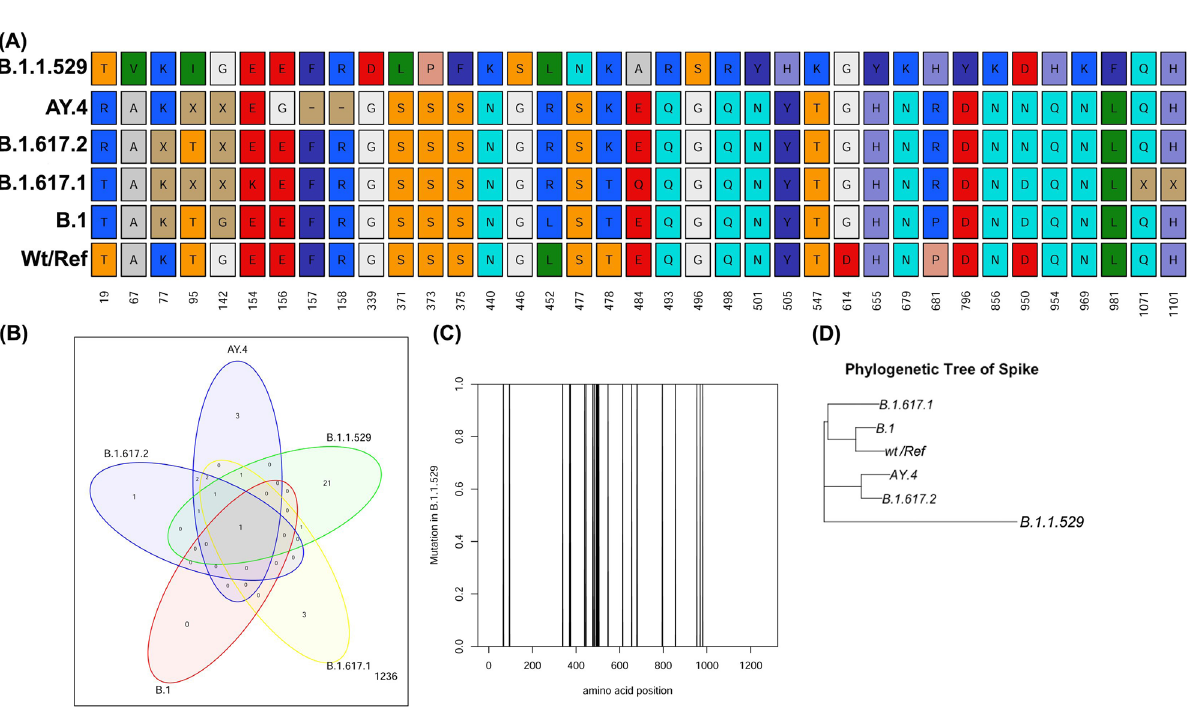
Figure 4. Hierarchical clustering of correlation matrix of various lineages. ( A ) Correlation plot of ( A ) different variants of SARS-CoV-2 lineages found in Indian population. ( B ) Correlation plot different states/UTs with respect to cases of Delta VoC lineage obtained per month.